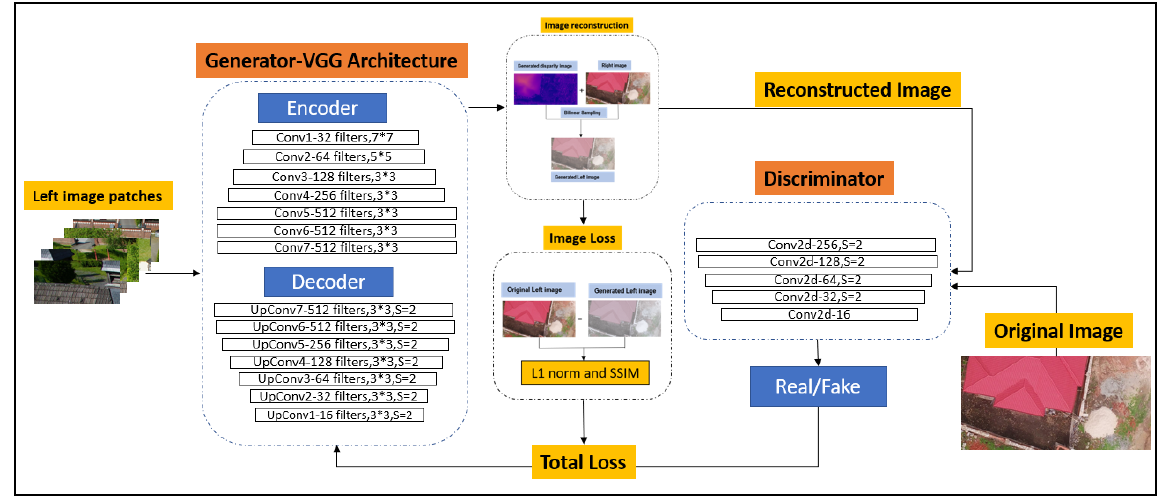
Figure 6. GAN architecture with Generator and Discriminator